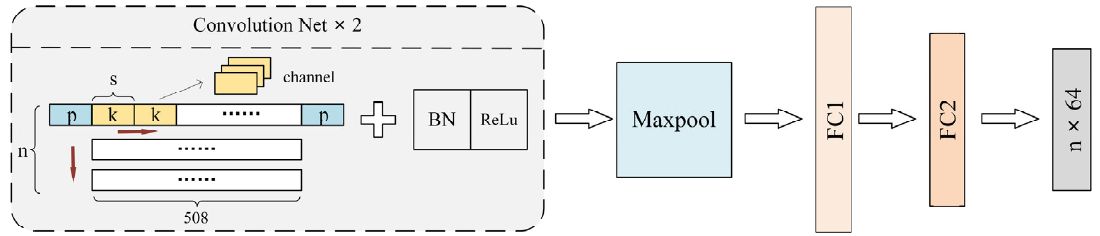
Figure 5. The FeatureNet structure proposed in this study.